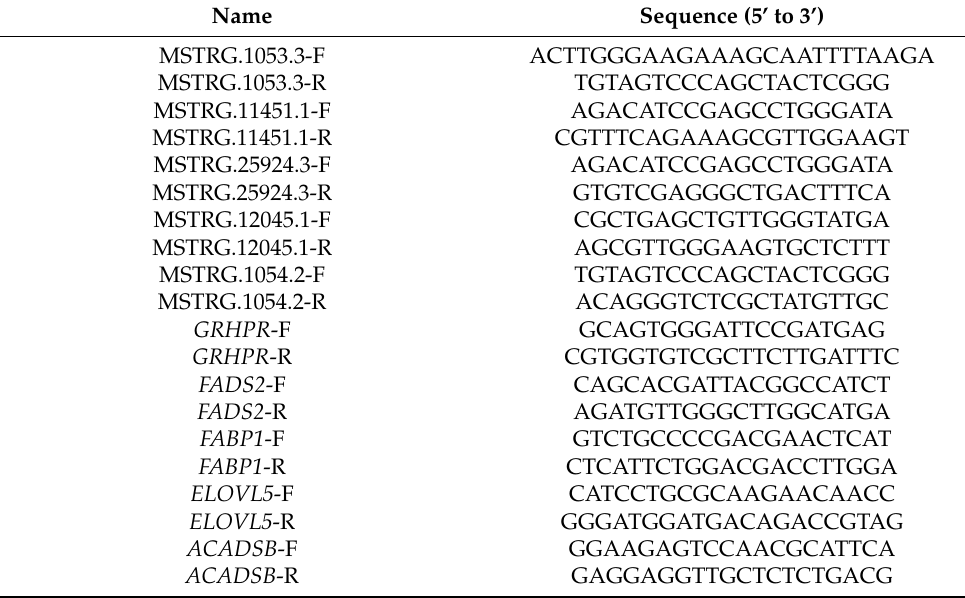
Table 1. Forward and reverse primers used for gene quantification by